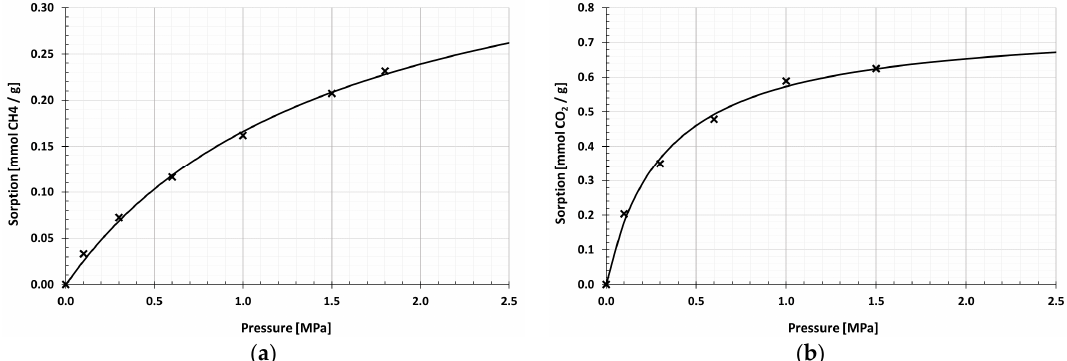
Figure 10. Sorption isotherms of calcined halloysite: ( a ) CH 4 sorption isotherm; ( b ) CO 2 sorption isotherm.